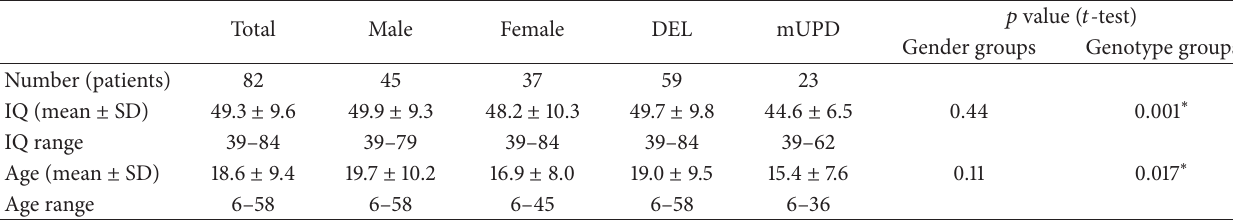
Table 1: Patient